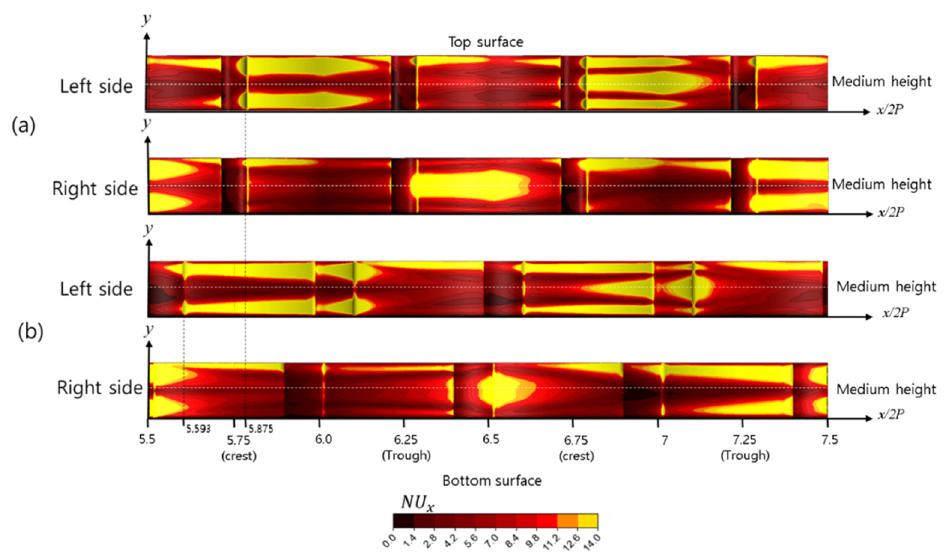
Figure 16. Local Nusselt number distributions on wavy walls: ( a ) reference design, and ( b ) optimal design (POD2).